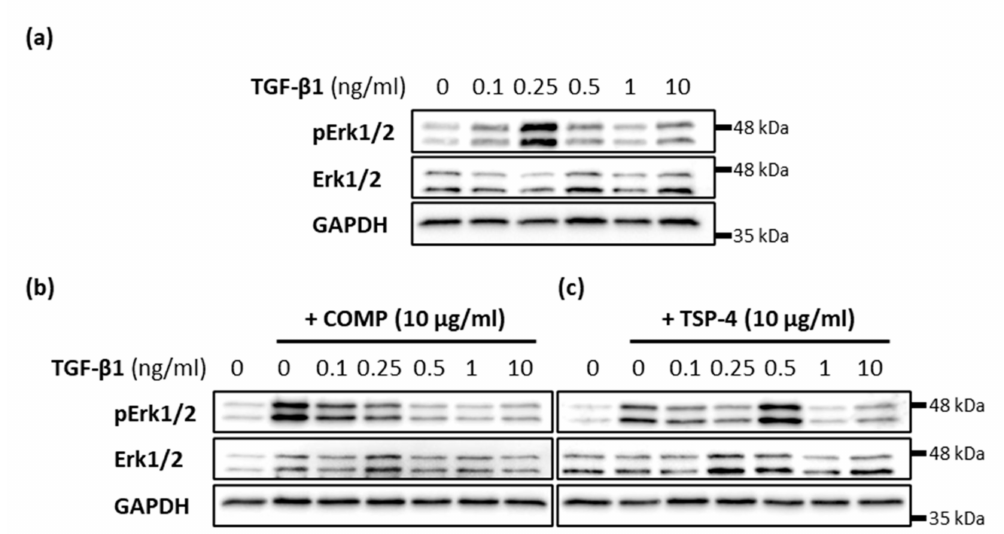
Figure 6. Modulation of TGF- β 1-induced Erk signaling in chondrocytes. Chondrocytes were stimulated with indicated concentrations of TGF- β 1 alone or in combination with COMP (10 µ g/mL) or TSP-4 (10 µ g/mL) before Erk1/2 proteins were detected by immunoblot. ( a ) Representative immunoblots show the concentration-dependent TGF- β 1 induced phosphorylation of Erk1/2 (pErk1/2) and total Erk1/2. Representative immunoblots show the influence of COMP ( b ) and TSP-4 ( c ) on the concentration-dependent TGF- β 1 induction of Erk1/2 phosphorylation. GAPDH was used as a loading control; ( n =